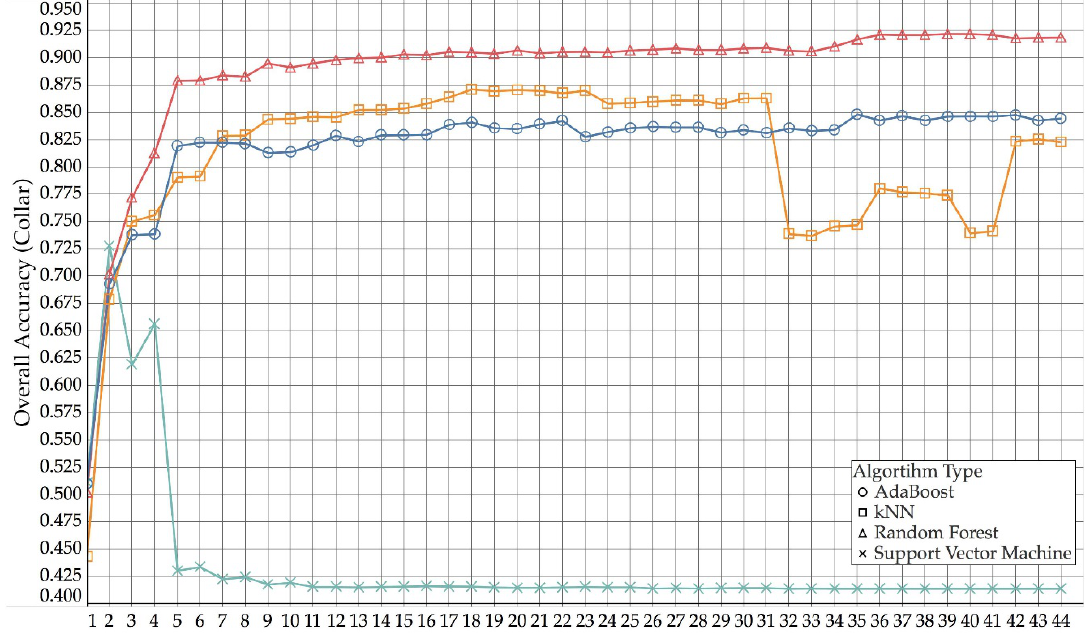
Figure 4. Comparison of overall accuracies for collar, over number of used features (AdaBoost, kNN, random forest and support vector machine).